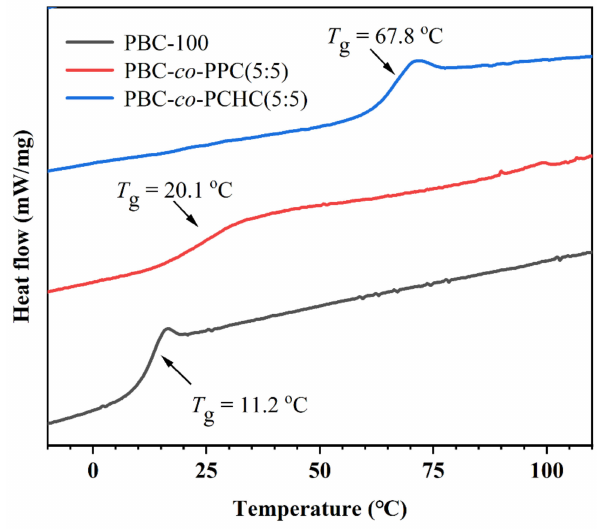
Figure 3. DSC analysis of the obtained